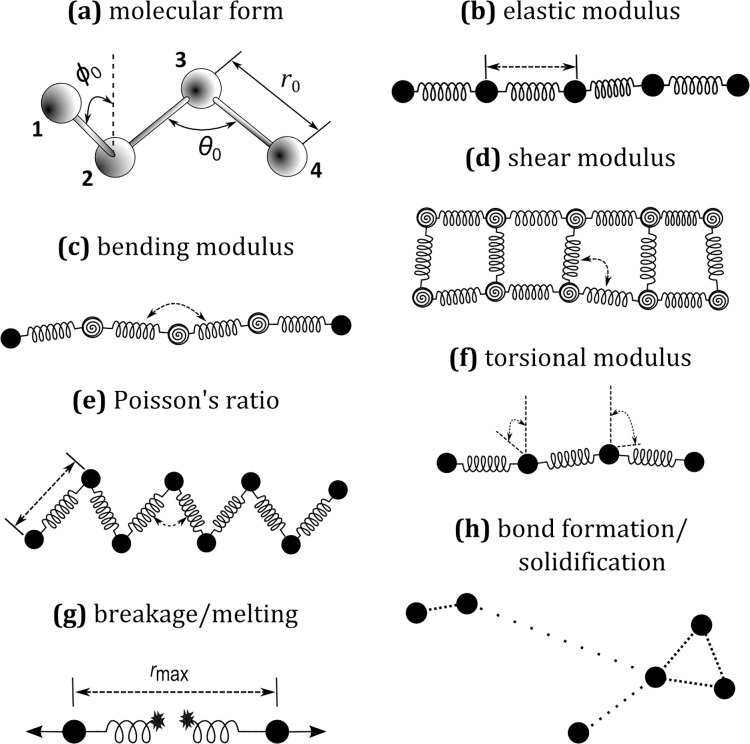
Coarse-grain modelling of solids and its molecular origin.